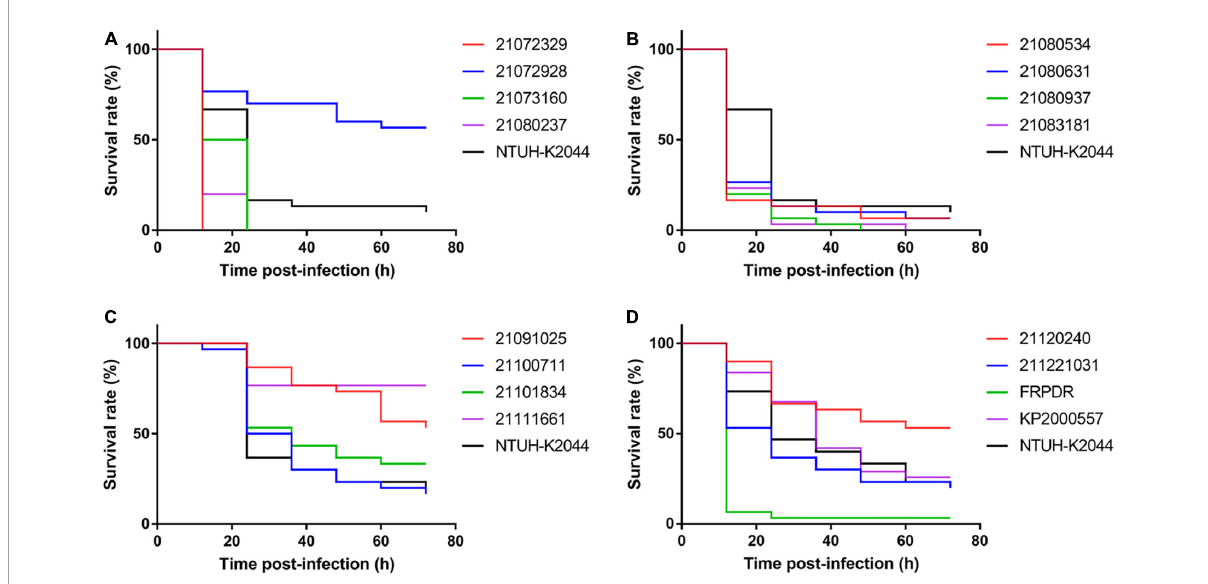
FIGURE1 ST11 isolates showed high virulence against Galleria mellonella . Using the G. mellonella infection model to evaluate virulence of ST11 K. pneumoniae isolates (1 × 10 6 CFU). (A–D) Are the G. mellonella infection model results of ST11 K. pneumoniae isolates.